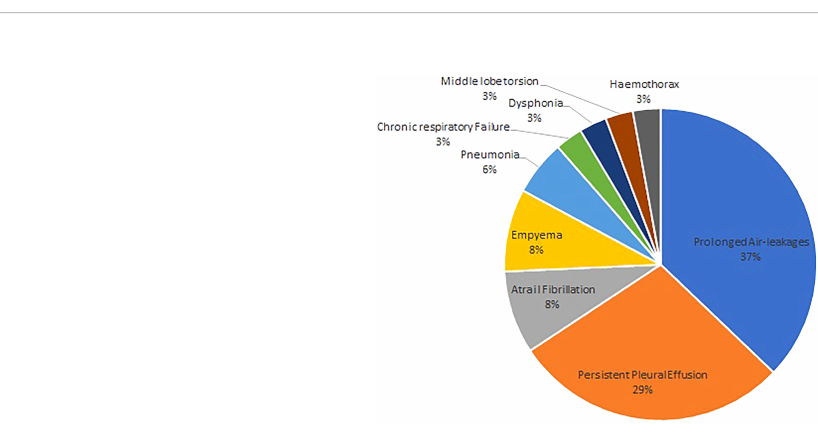
FIGURE 1 Distribution of the different postoperative